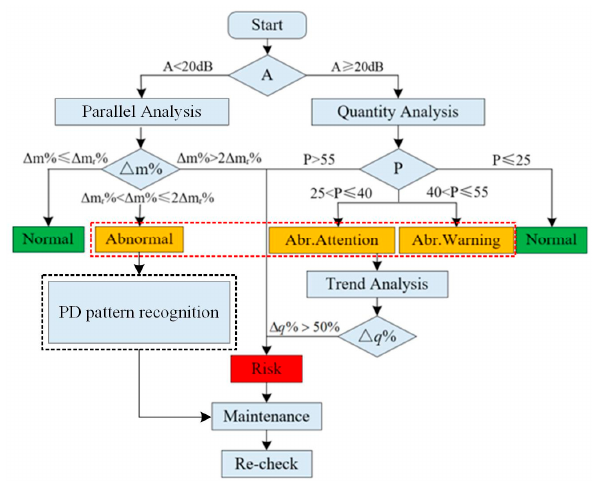
Figure 21. Diagnosis procedure in the decision layer.